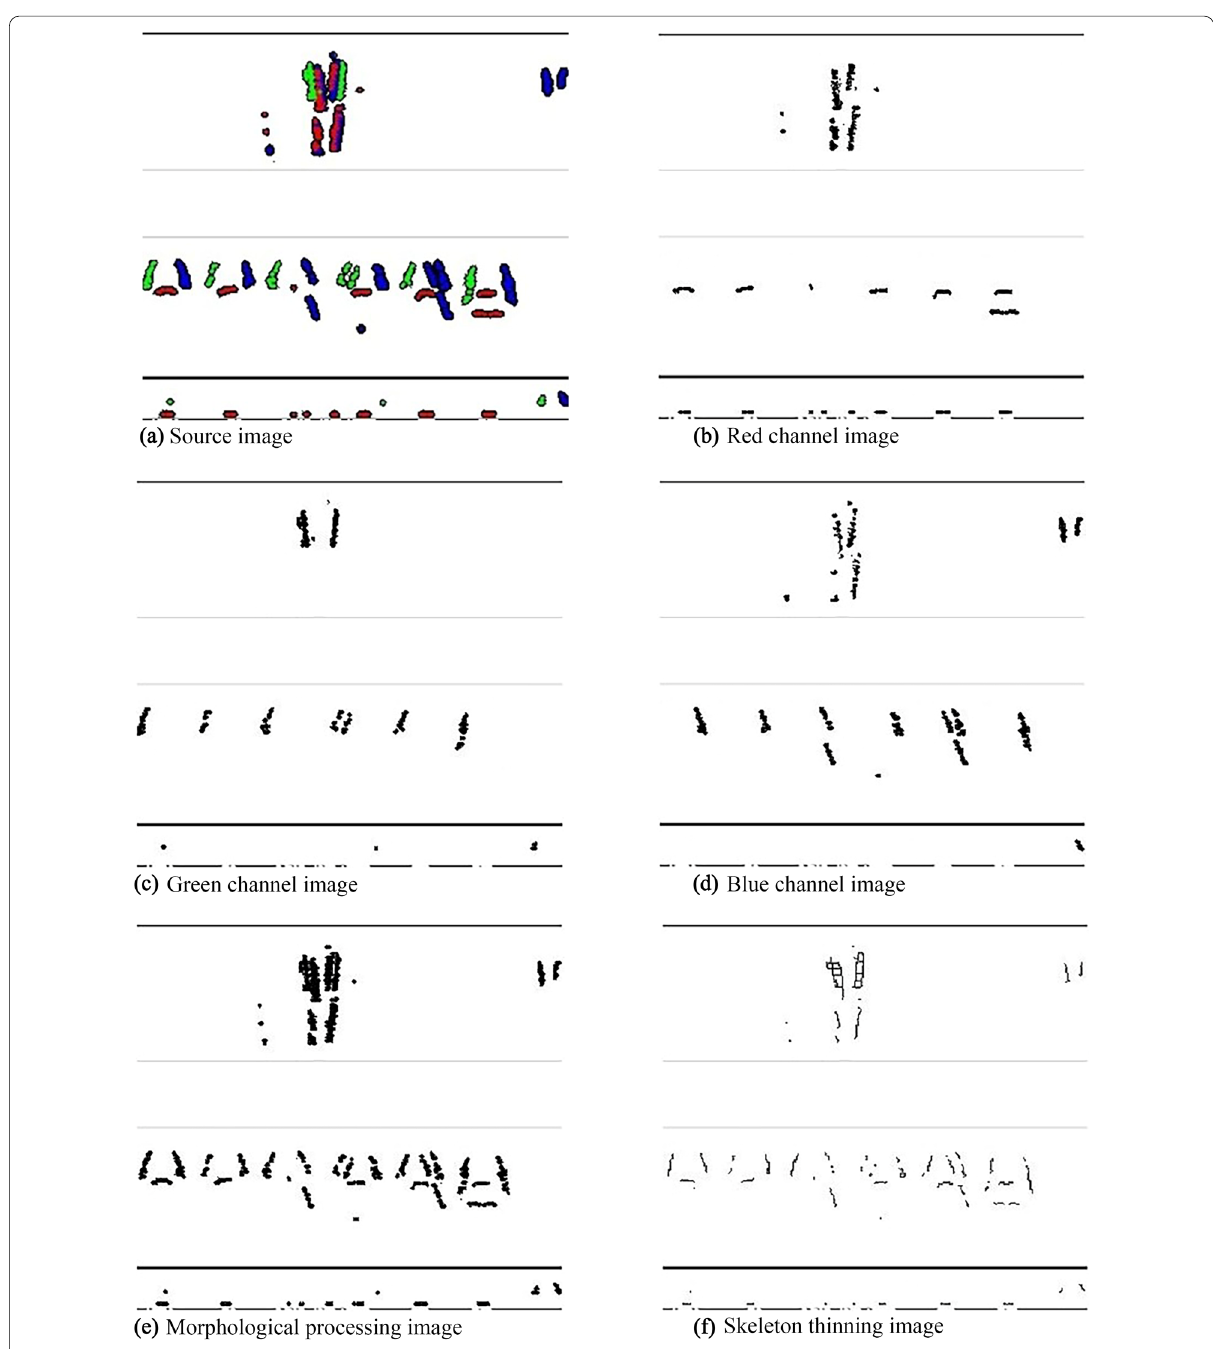
Figure 8 Source image and its preprocessing